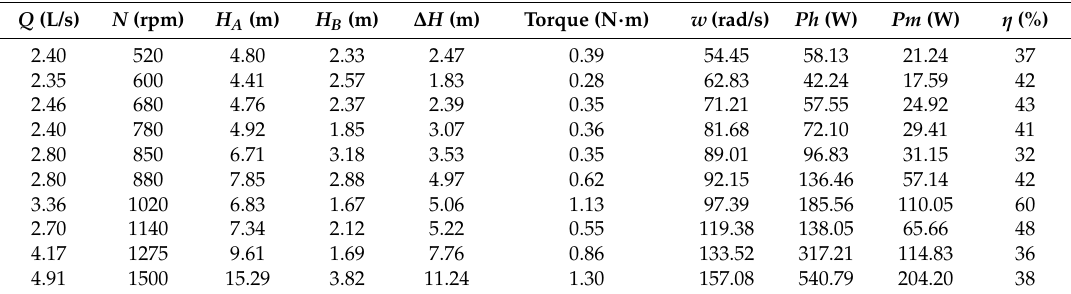
Table 4. Results obtained in computational fluid dynamics (CFD)